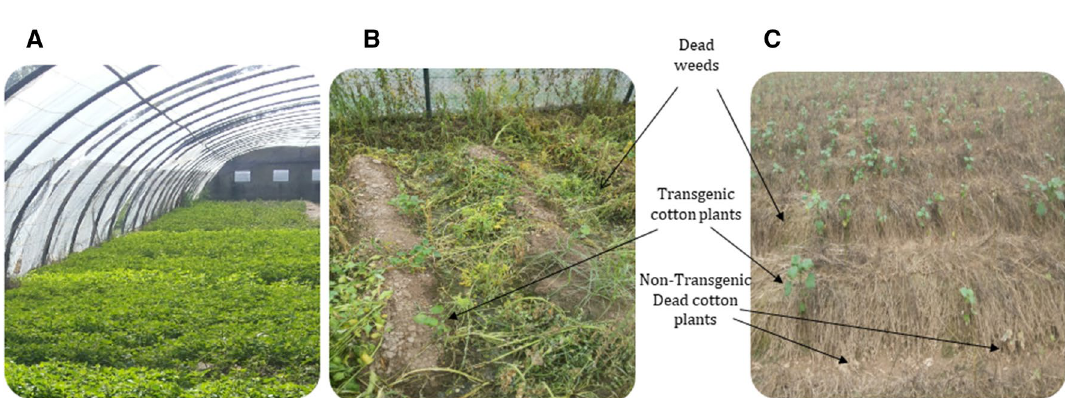
Figure 5. Glyphosate spray assay of transgenic cotton plants at day 3 and 5 ( A ) Transgenic cotton plants along with weeds before spray, ( B ) View of cotton field after 3 days of glyphosate spray, arrow indicate the necrotic weeds and survival of transgenic cotton plants ( C ) View of cotton field after 5 days of glyphosate spray, arrow indicate the complete mortality of weeds and survival of transgenic cotton